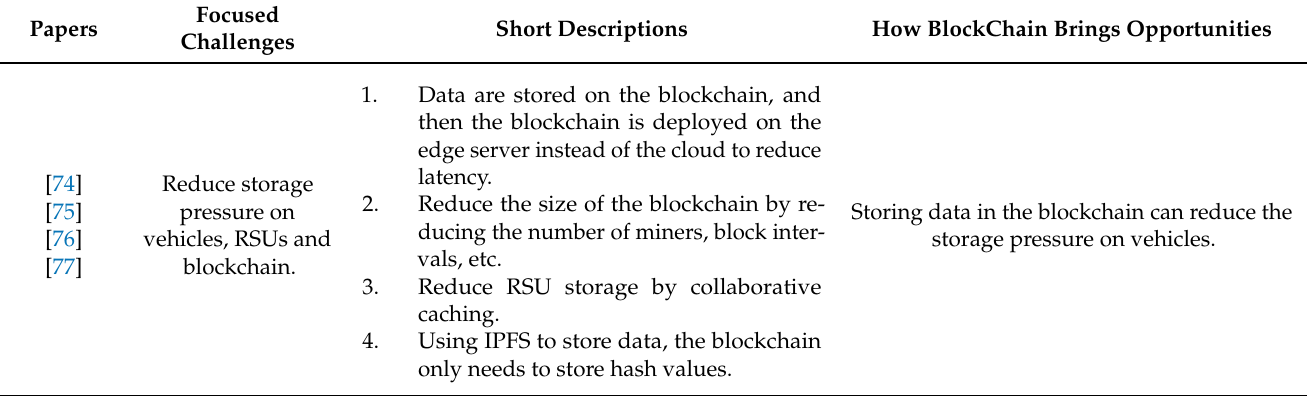
Table 1. Data Management Related